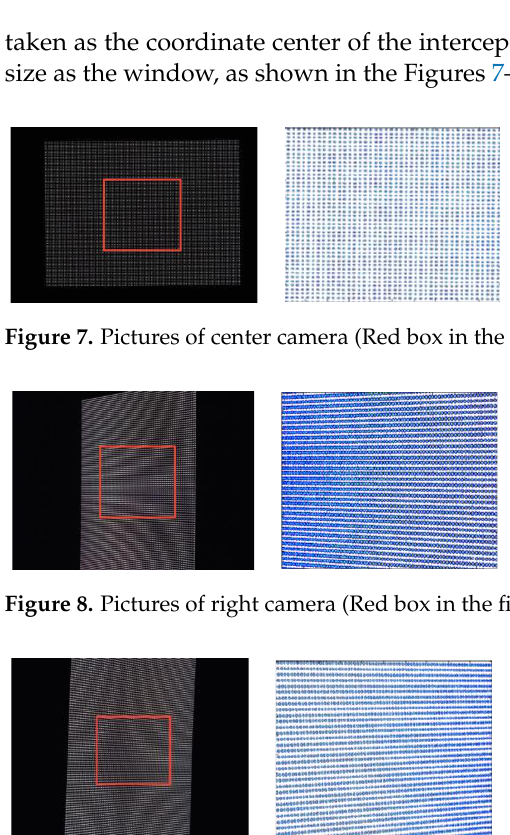
Figure 9. Pictures of left camera (Red box in the figure is the window).